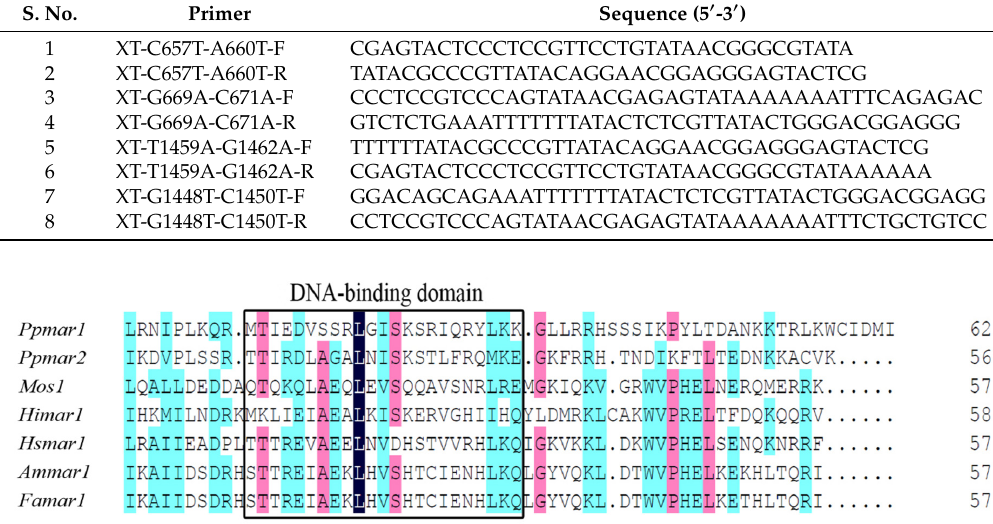
Figure 6. The homologous alignment of amino acid sequences of DNA binding domain (DBD) of Ppmar1 transposase and the DBD of Ppmar2 transposase in the following DBDs: Mos1 from Drosophila mauritiana , Himar1 from horn fly, Hsmar1 from human genes, Ammar1 from European honey bee, and Famar1 from earwig.